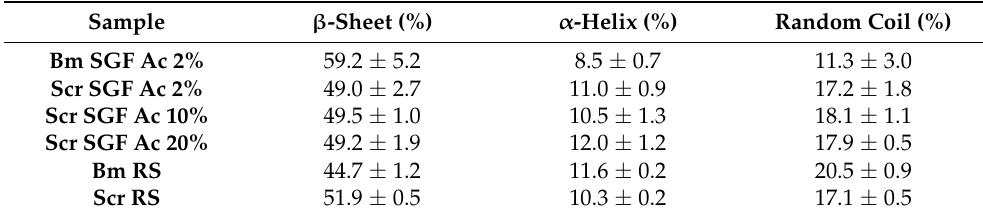
Table 3. Contribution of the different secondary structures to the microstructure of silkworm gut fibres (SGF) produced from silk glands of S. c. ricini (Scr SGF) under different experimental conditions and from B. mori (Bm SGF), as well as those correspondent to raw silk fibroins produced by both species of silkworms (named as Scr RS and Bm RS, respectively). Expressed as average values ± standard deviation. Sample β -Sheet (%) α -Helix (%) Random Coil